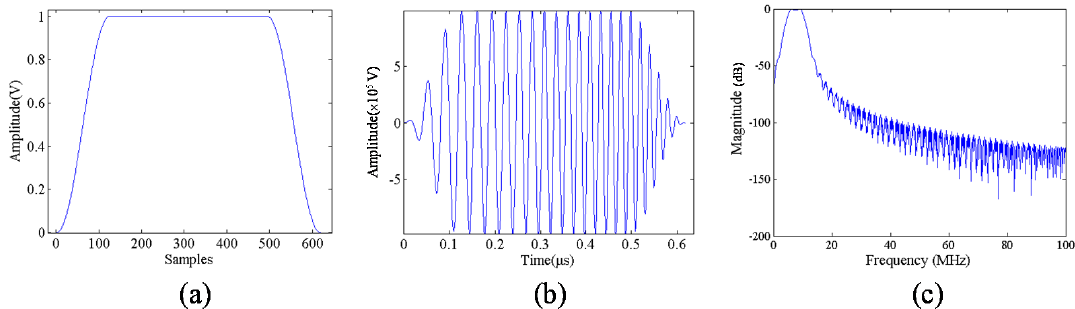
Figure 5. ( a ) Tukey window function; ( b ) chirp with Tukey window; and ( c ) frequency responses.